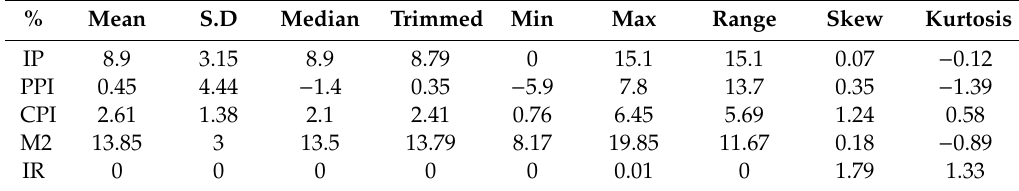
Table 4. Summary statistics of macroeconomic variables during the CSI 300 futures research